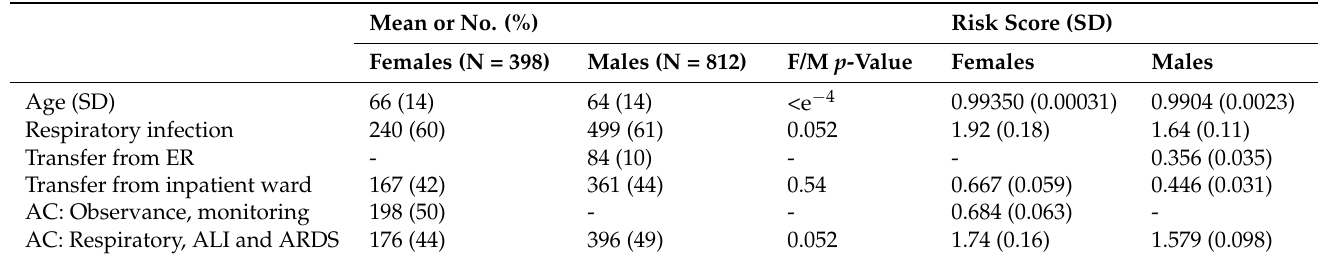
Table 4. Pre-ICU covariates for outcome “mechanical ventilation”. Table shows case numbers in the sub-cohorts as well as the averaged regression coefficients for the selected features.